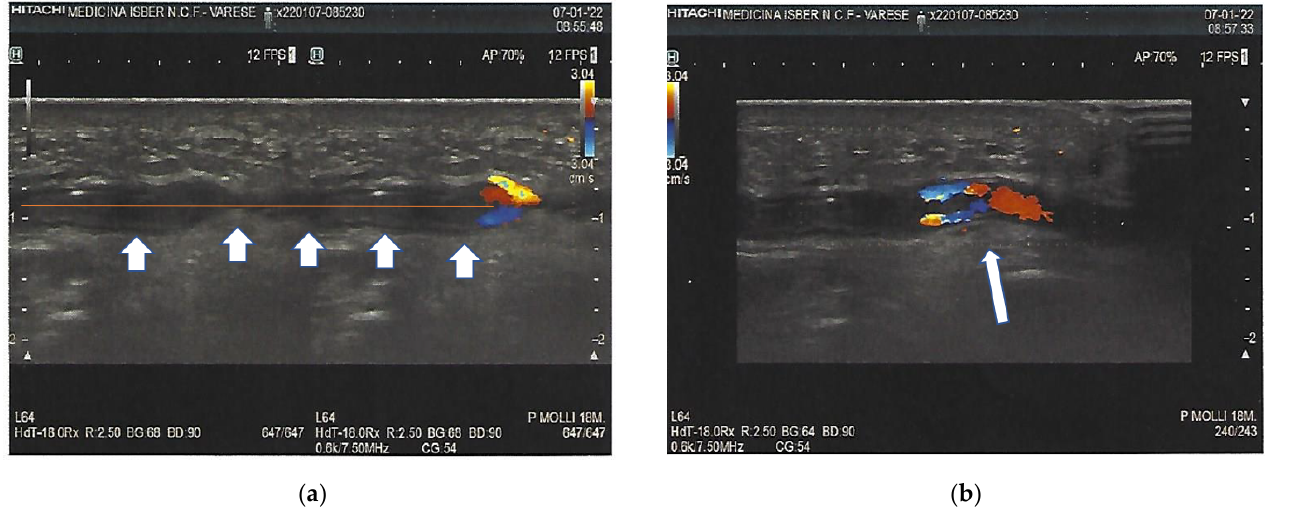
Figure 2. Subocclusive arterial thrombosis of the arcuate branch of the ulnar artery. The arrows indicate the thrombosis in all its length ( a ); Doppler image shows how the blood flow spreads by crossing the intraluminal thrombus (arrow) ( b ).